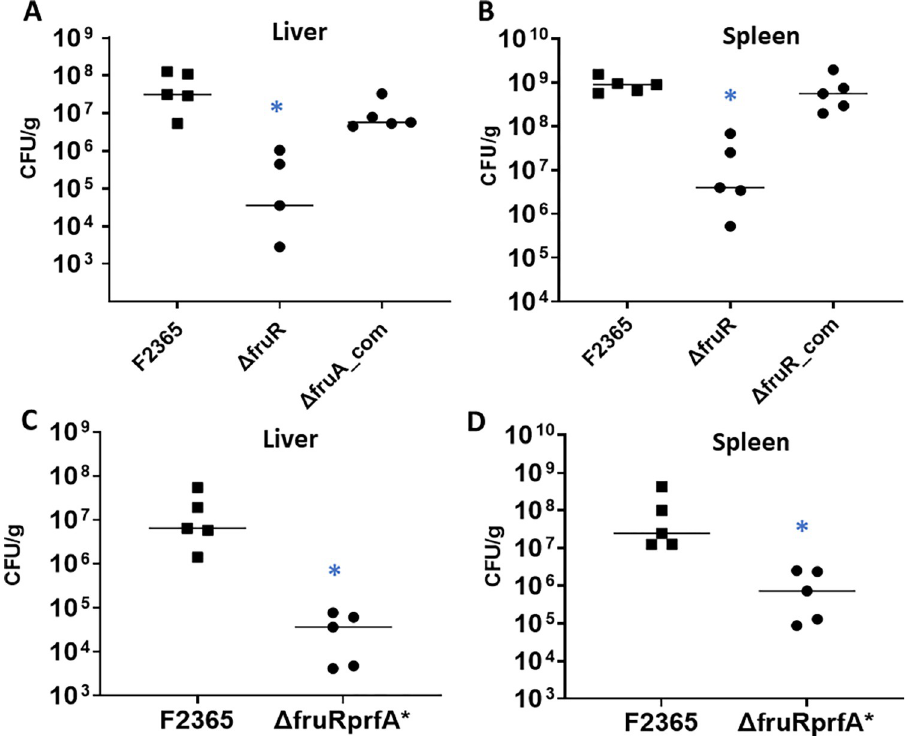
Fig 1. The Δ fruR strain is attenuated in mice at 72 hours post-infection and PrfA activation does not rescue attenuation of the Δ fruR strain. Each animal group (5 mice per cage) was IV infected with indicated strain. Livers (A and C) and spleens (B and D) were harvested at 72 hours post-infection and bacterial concentrations were determined. Data were analyzed using a nonparametric Mann-Whitney test. Median numbers for each strain are indicated by horizontal lines. Asterisks indicate significant differences (P < 0.05) compared to the wildtype.